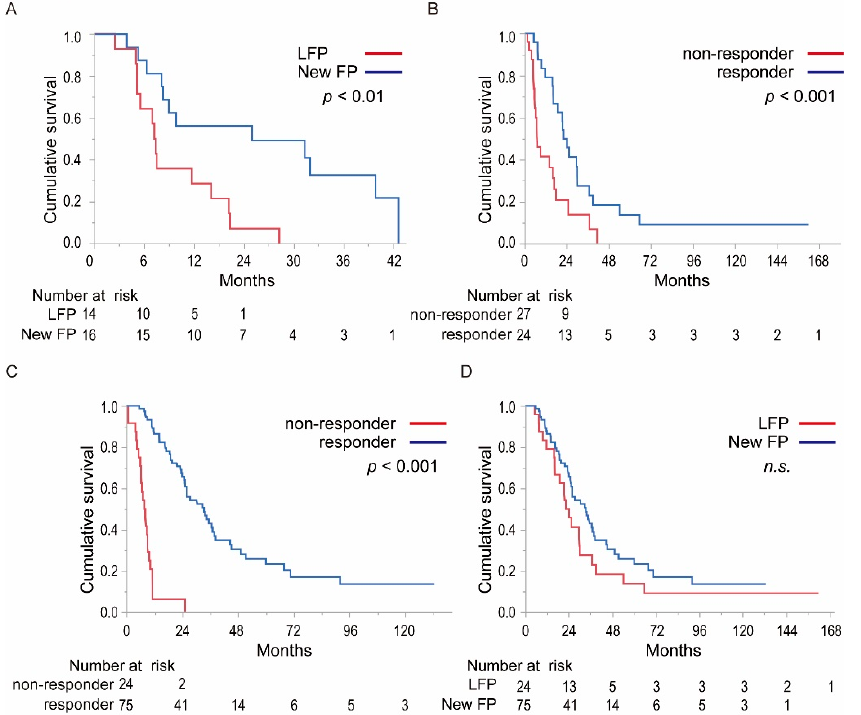
Figure 3. Detailed comparison of the survival curve of patients with HCC treated with either LFP or New FP. ( A ) Comparison of the survival curve of patients accompanied by PVTT into the portal trunk of the LFP and New FP groups. The MST of the LFP and New FP were 9.2 and 18.7 months, respectively. The MST of the New FP was significantly superior to that of LFP in patients with HCC accompanied with PVTT into portal trunk ( p < 0.01). ( B ) Comparison of the survival curve of the responders and non-responders in the LFP group. The MST of the responders and non-responders in the LFP was 23.2 and 7.2 months, respectively ( p < 0.001). ( C ) Comparison of the survival curve of